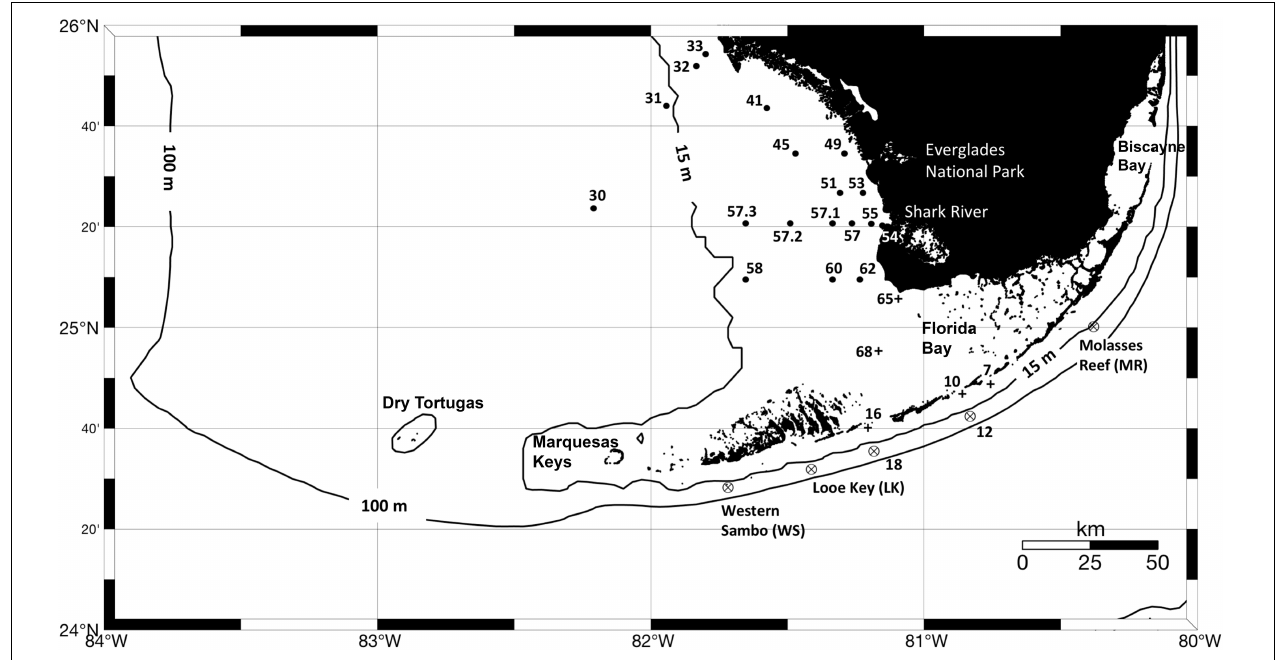
FIGURE 1 | Location of sites sampled during the three oceanographic expeditions conducted in March, May, and September of 2016 led by the NOAA South Florida Program and the Marine Biodiversity Observation Network (MBON). Crossed circles indicate stations mostly occupied by oligotrophic waters, cross symbols indicate stations influenced by Florida Bay waters, and black circles show locations of sampled sites on the west Florida shelf. Measurements collected at each site include temperature, salinity, inorganic nutrients (DIN, SRP and Si), CDOM absorption at 443 nm [a g (443)], phytoplankton HPLC pigments, and filter pads for specific absorption of phytoplankton and non-algal particles (a phy and a d ,